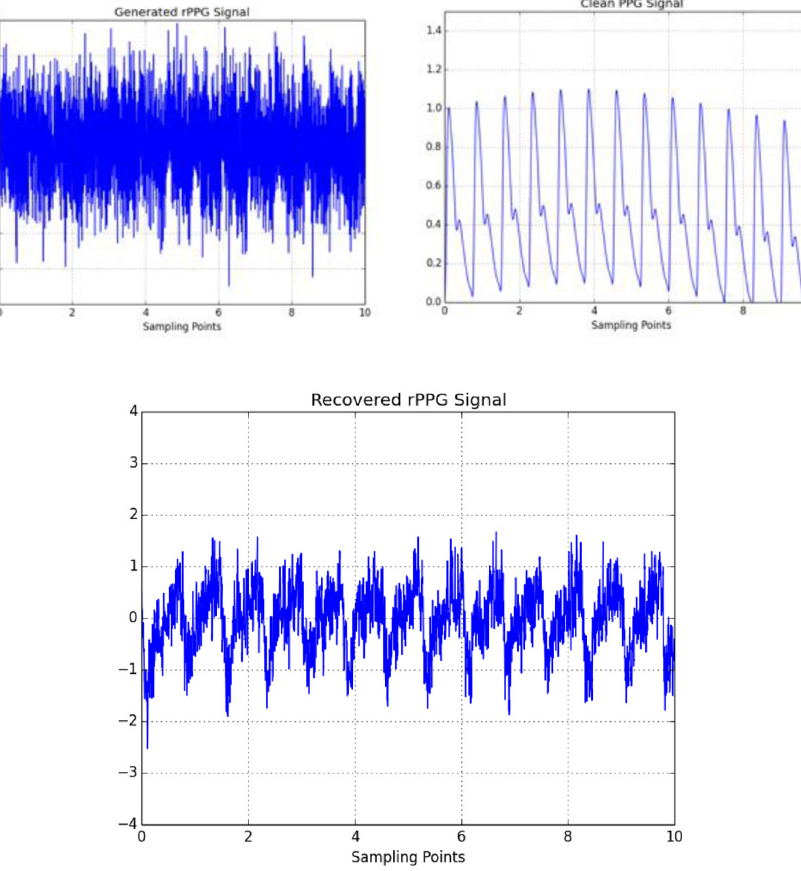
Figure 9. Recovered rPPG